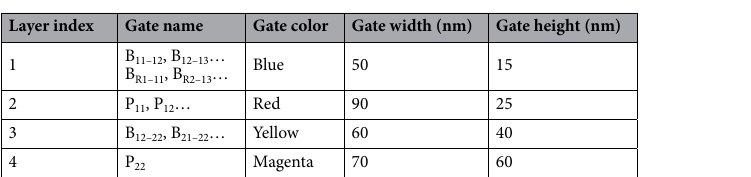
Figure 1. Schematics of a device design with a 3 × 3 QD array ( a ) Device layer structure and 3 × 3 QD array schematic in Si QW. Silver spheres with arrows represent spins in QDs. Labels B and R in the array represent barrier gates and reservoirs, respectively. ( b ) Layer stack of overlapping Al gates. The electron spin symbol is displayed when the corresponding control gate electrode is fabricated in the layer. This device can be fabricated with four layers of overlapping gates. An overlay accuracy of 10 nm is assumed. ( c ), ( d ) Cross sections of the QDs (A–A ′ ) and barrier gates (B–B ′ ) in ( b ). The gate thickness increases in the upper layers to ensure gate continuity. In (d), the black and gray areas are both SiO 2 , with the Si layer underneath etched in the latter. ( e ) Electrostatic potential in the Si QW at applied voltages of 0.6 V on plunger gates and 0.4 V (0.3 V) on the barrier gates between QDs (between a QD and a reservoir). ( e ) is drawn with COMSOL Multiphysics ver. 5.5 (https:// www. comsol. com).